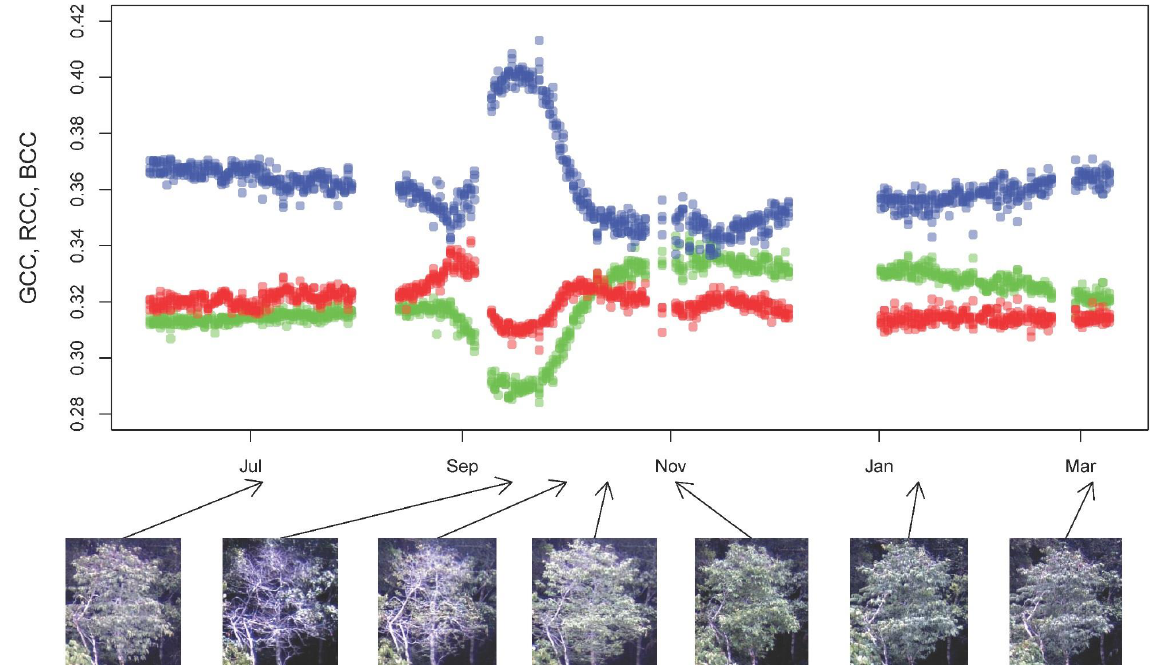
Figure 4. Green (GCC), red (RCC), and blue (BCC) chromatic coordinates for a single tree ( Wrightia laevis ) at the Cow Bay tropical rainforest OzFlux site (Fig. 2; site 1, AU-Cow), Queensland, Australia. Quick leaf shedding and flushing events are well captured by the